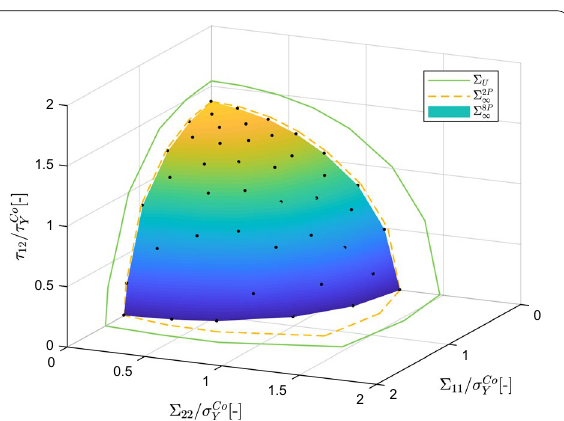
Figure 6 Discrepancy between shear moduli calculated from two approaches